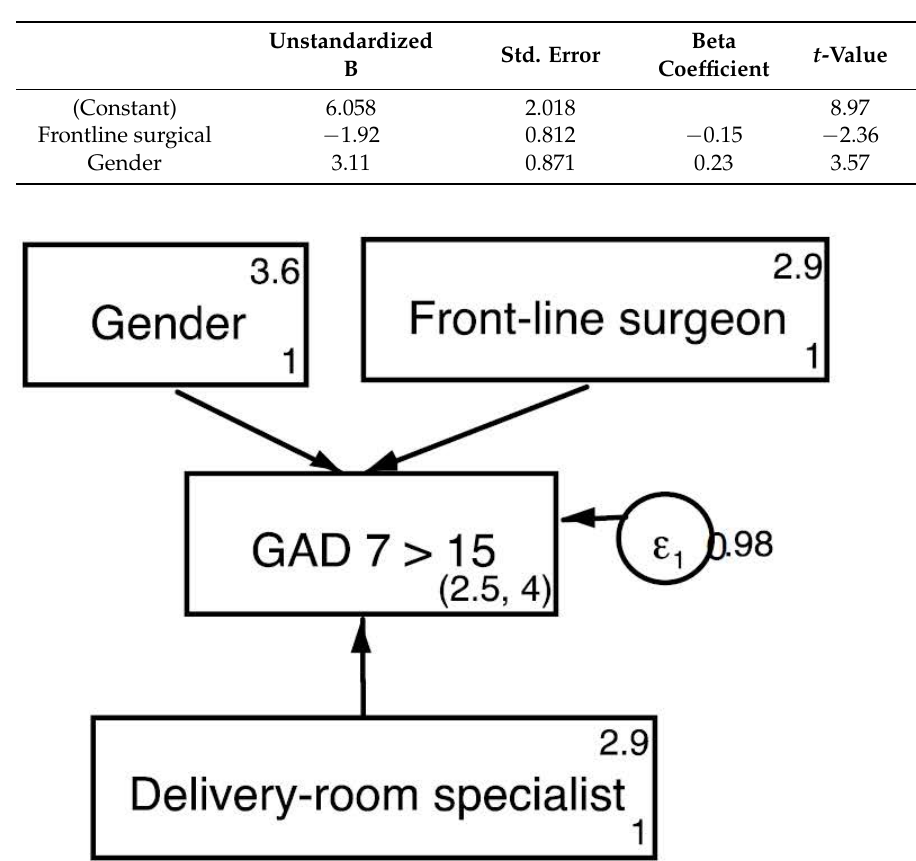
Figure 3. Predictive model for positive GAD screening. Chi sq (baseline vs. saturated) = 3.853; p < 0.278; Population error RMSEA = 0.001 ( p < 0.05); Akaike’s information criterion = 875.80.; Bayesian information criterion = 892.64; Comparative fit index = 1; Tucker–Lewis index = 1; Stan- dardized root mean squared residual = 0.001; Coefficient of determination =